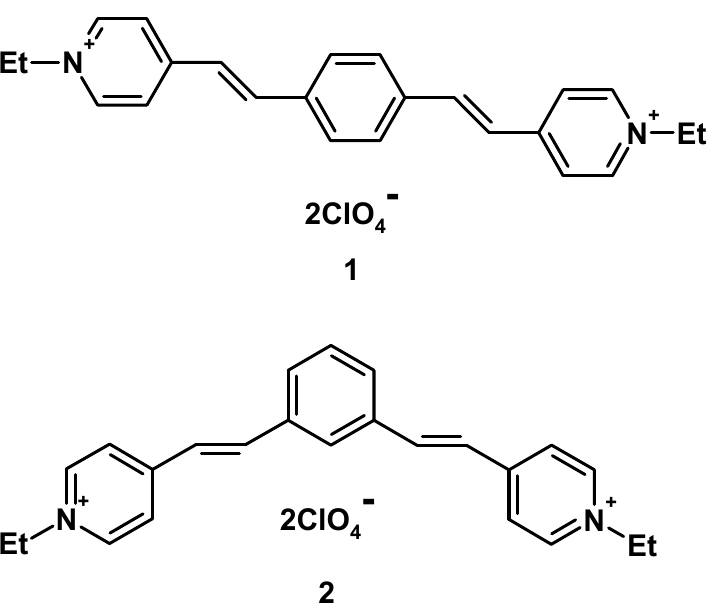
Figure 1. Structures of 4,4’-{1,4-phenylenebis[(E)-ethene-2,1-diyl]}bis(1-ethylpyridinium diper- chlorate ( 1 ) and 4,4’-{1,3-phenylenebis[(E)-ethene-2,1-diyl]}bis(1-ethylpyridinium) diperchlorate ( 2 ).